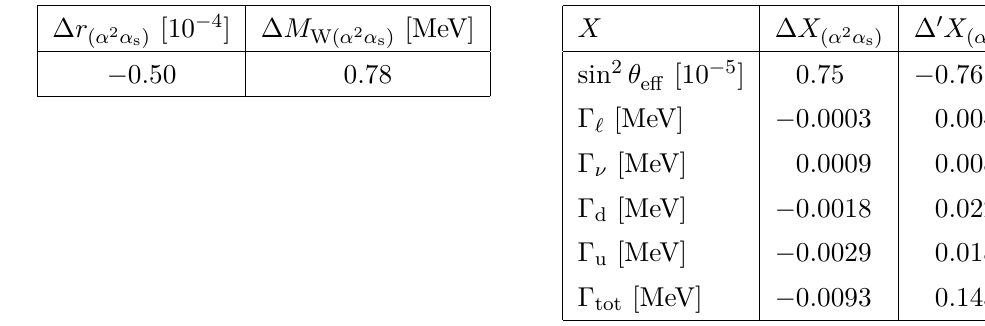
Table 4 . Leading fermionic three-loop corrections to EWPOs at O ( α 2 α s ) with MS prescription for the top